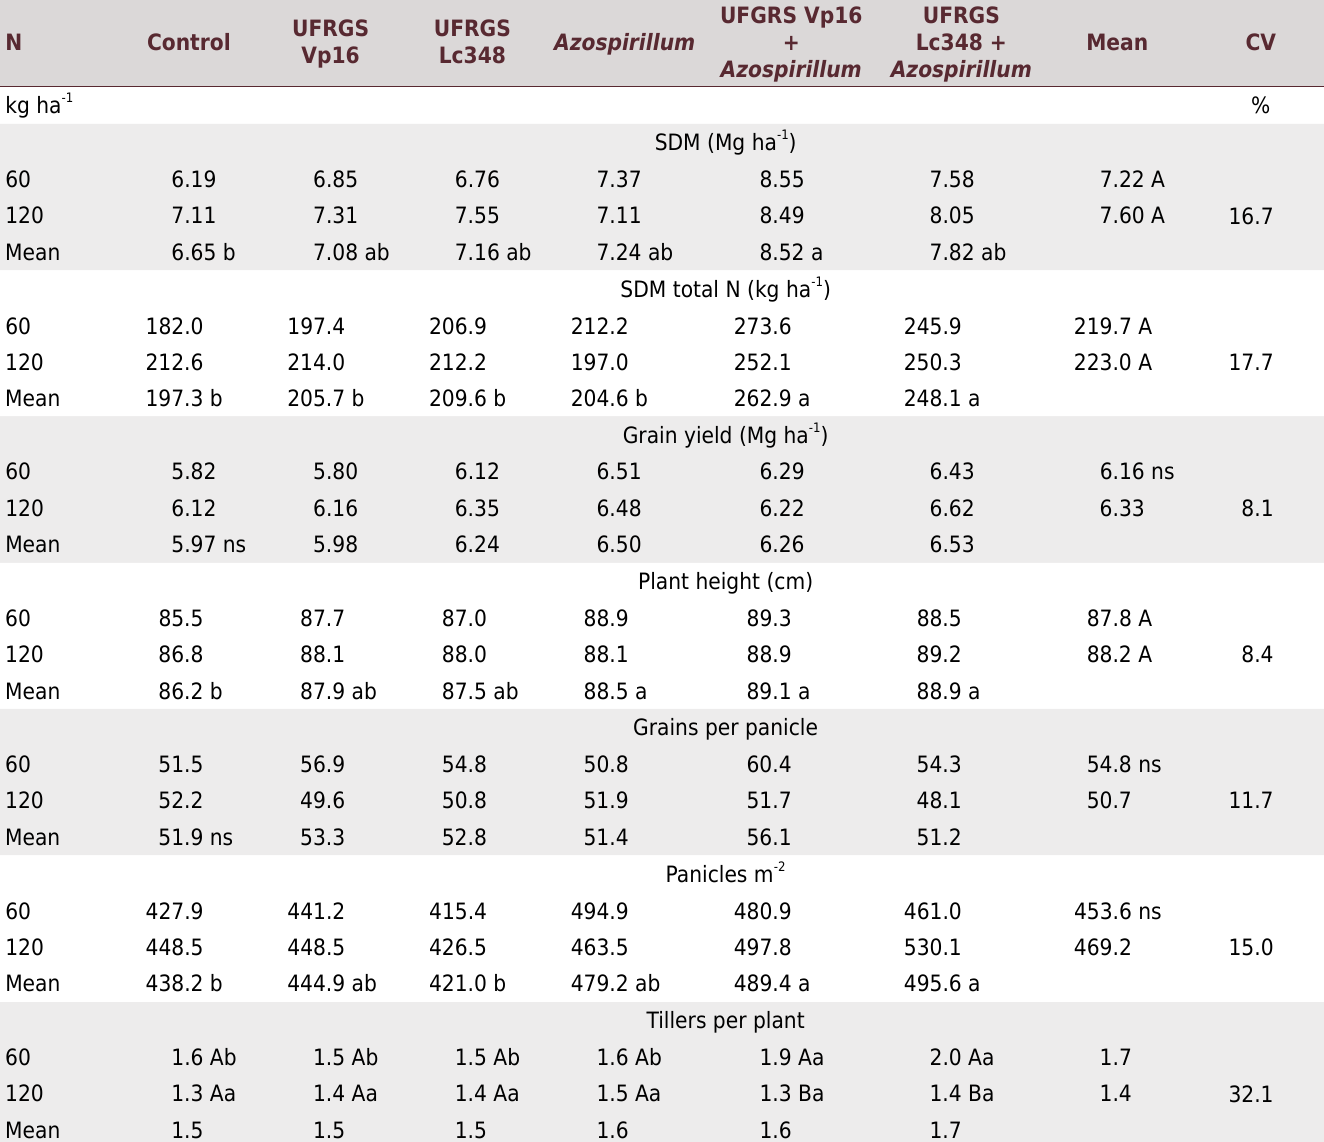
Table 3. Production of shoot dry matter (SDM), SDM total N, grain yield, plant height, grains per panicle, panicles m -2 , and tillers per plant of the wetland rice cultivar Puitá INTA inoculated with diazotrophic bacteria in the presence of 60 and 120 kg ha -1 of nitrogen